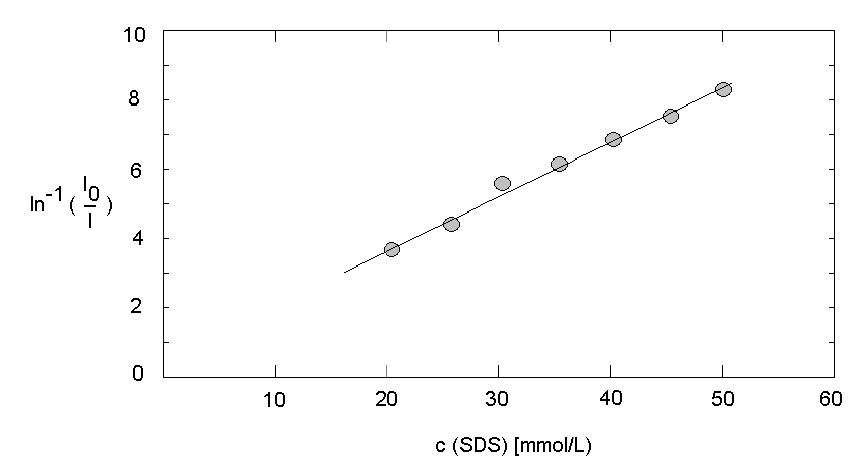
Figure 2. Dependence of fluorescence intensity (Ru(bipy) 32+ ) in solutions with constant quencher concentration (99 µmol/L) on surfactant concentration without flow inside PTFE